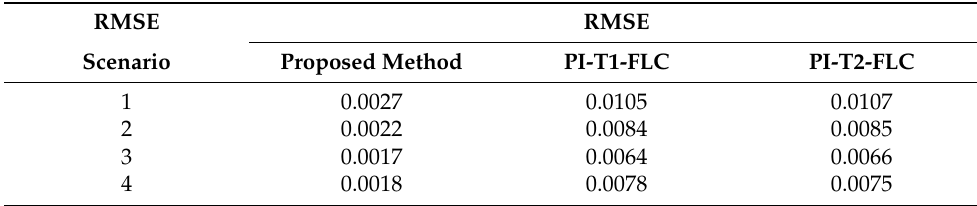
Table 3. Regulation comparison by various controllers.